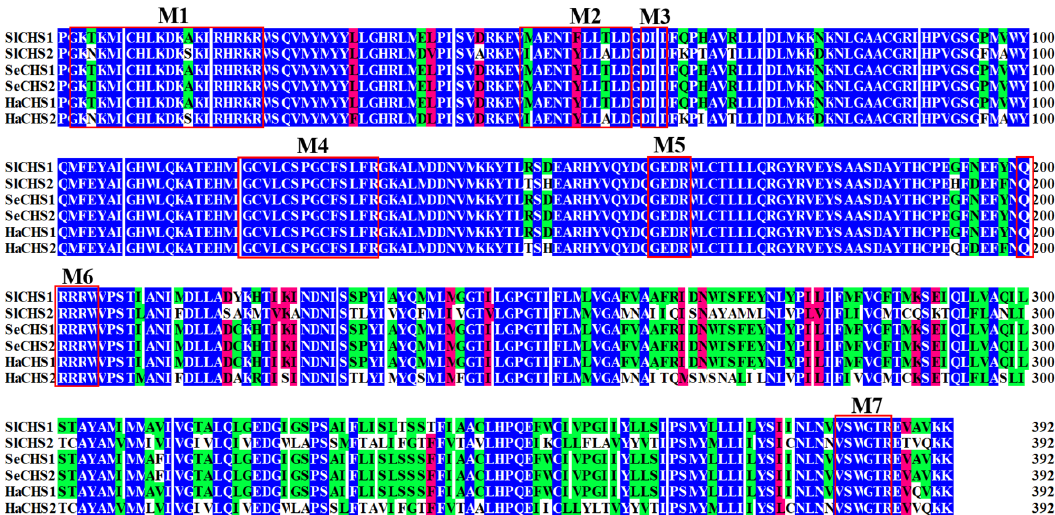
Figure 1. Multiple sequence alignment of the conserved catalytic domain of the chitin synthases (CHSs) from three insect species. CHSs are from Spodoptera litura (Sl), Spodoptera exigua (Se) and Helicoverpa armigera (Ha). Seven characteristic motifs (M 1–7) for insect chitin synthases are indicated with red